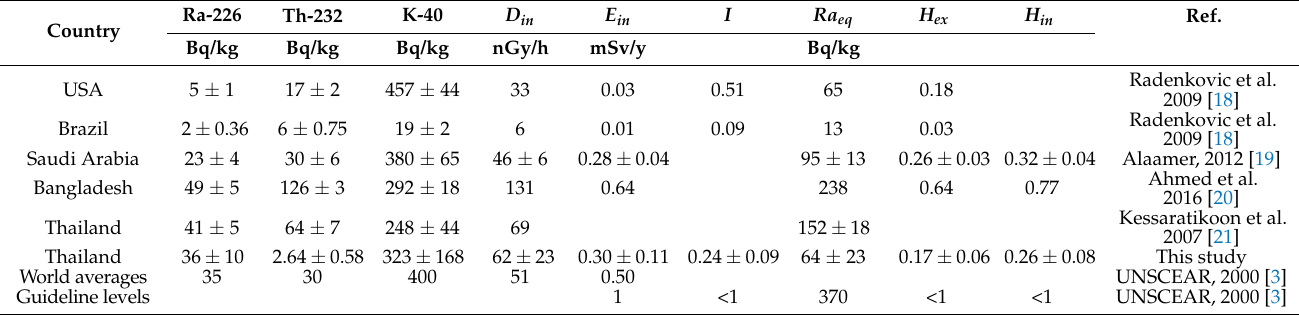
Table 4. Comparison of the average results of Ra-226, Th-232, and K-40 concentrations and D in , E in , I , Ra eq , H ex and H in values from sand samples in this study with reports in the different countries and the world averages and the guideline